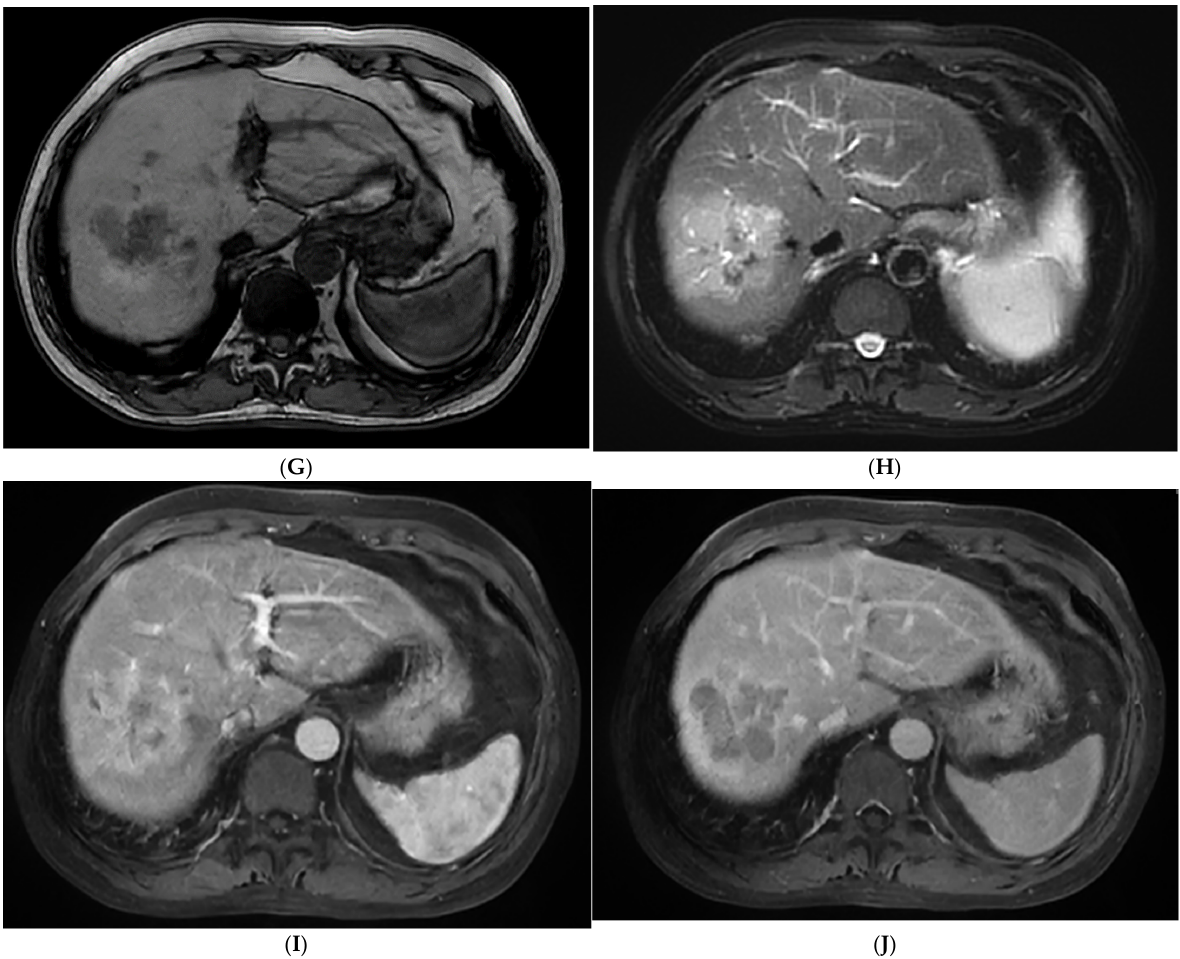
Figure 1. The contrast-enhanced ultrasound (CEUS) and contrast-enhanced magnetic resonance im- aging (CEMRI) of steatohepatitic hepatocellular carcinoma (SH-HCC). A heterogeneous hyperech- oic lesion was detected in the right lobe of the liver ( A ). Short linear blood flow signals were seen in the peripheral of mass ( B ). As seen via CEUS, the hepatic nodule did not show rim, peripheral dis-continuous or heterogeneous hyperenhancement in the early arterial phase ( C ). During the portal venous phase, it was continuous iso-enhancement ( D ). It exhibited mild washout in the late phase ( E ). The hepatic lesion was heterogeneous hypointense on T1WI ( F ). A signal drop in the T1WI opposed-phase was observed ( G ). It was marked as hyperintense on unenhanced T2WI ( H ). After injection of contrast agent, the hepatic lesion showed non-rim hyperenhancement in the arterial phase ( I ). It became hypo-intensity during the late phase ( J